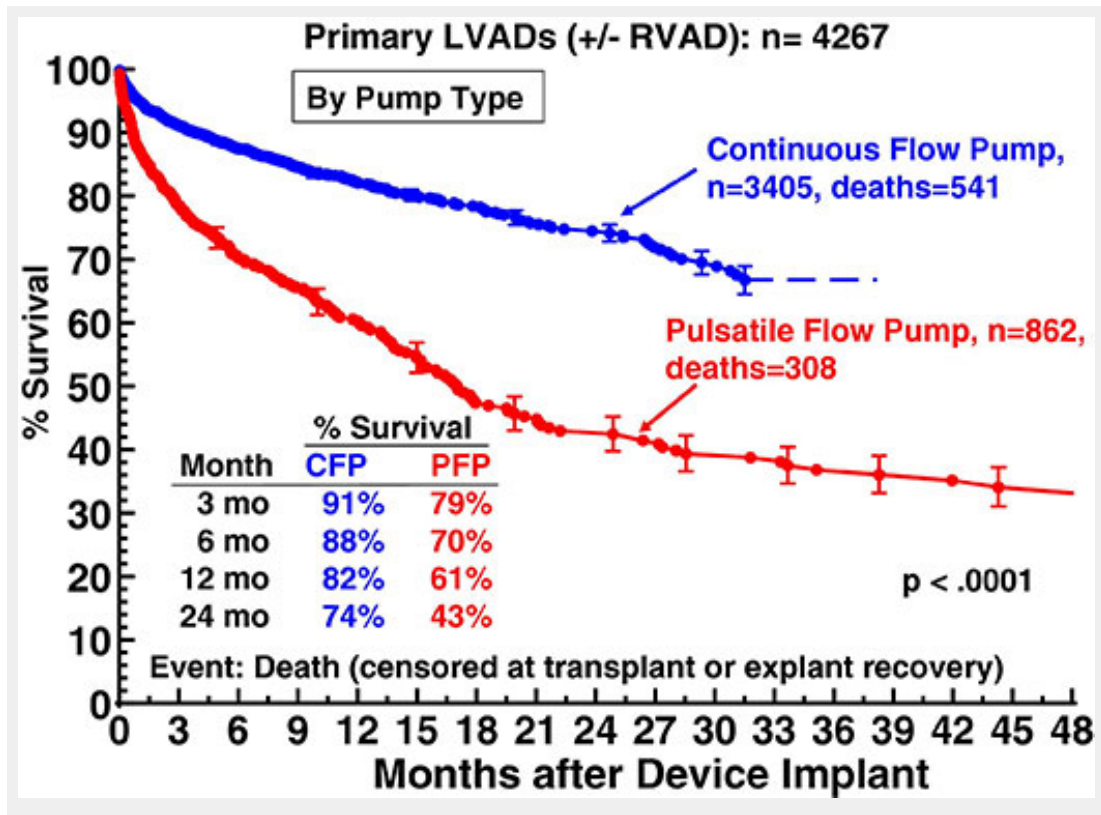
Figure 4 Actuarial survival following implantation of continuous-flow (CFP) versus pulsatileflow pumps (PFP). © 2012 Elsevier. Kirklin JK, Naftel DC, Kormos RL, Stevenson LW, Pagani FD, Miller MA, et al. The Fourth INTERMACS Annual Report: 4,000 implants and counting. J Heart Lung Transplant 2012;31:117–26 [13]. Reprinted with kind